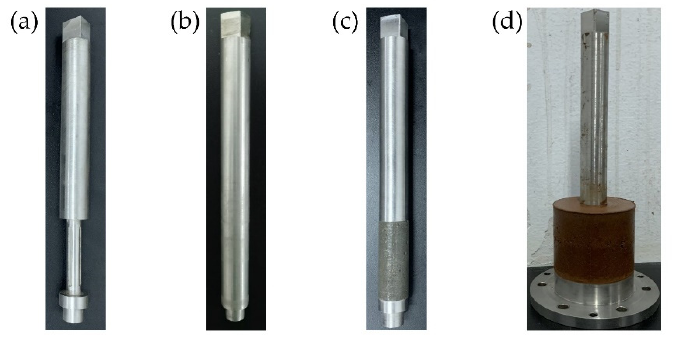
Figure 5. The structure rods and clay–structure specimen: ( a ) rotating shaft; ( b ) metal rod; ( c ) mortar rod; ( d ) clay–structure specimen.